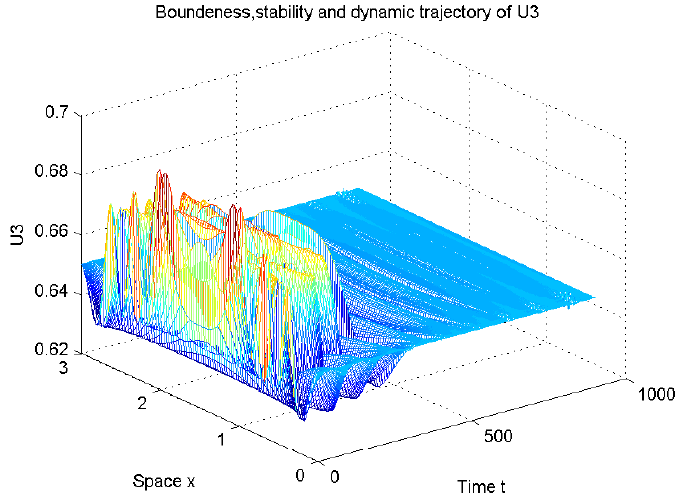
Figure 16. Computer simulation of dynamics of the price exponent U 3 .